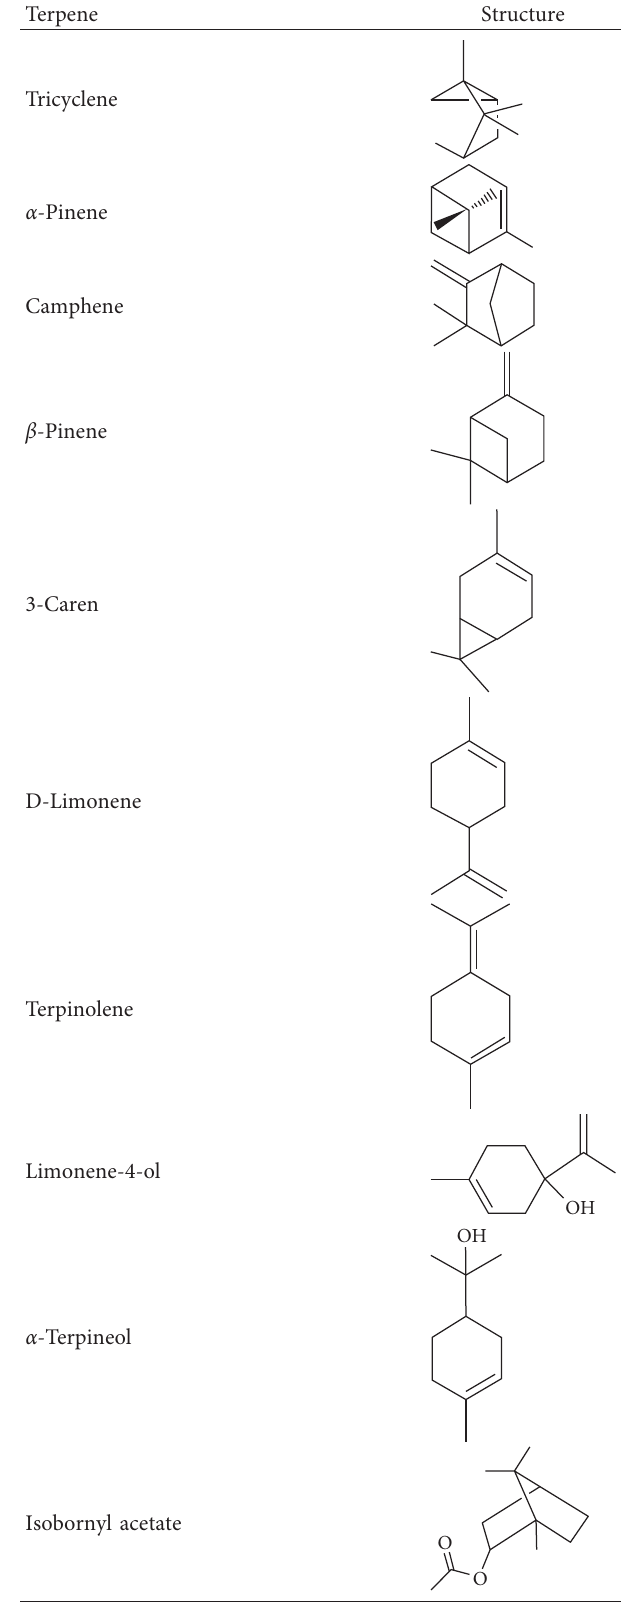
Table 9: Chemical structure of Pistacia vera L. hull essential oil terpenes.